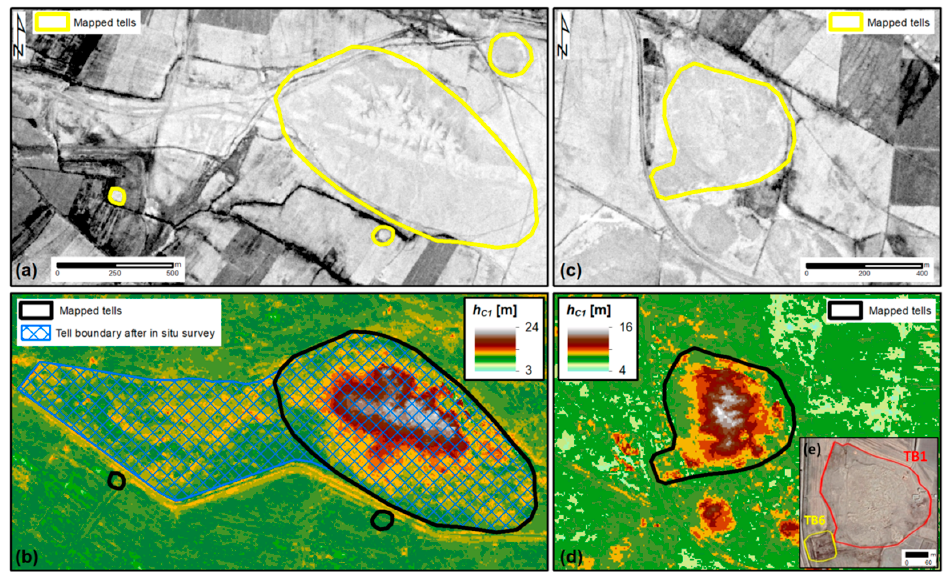
Figure 17. Zoomed views of tells ( a , b ) Bismaya H882 and ( c – e ) T ū l ū l al-Baqarat TB1 and TB6 showcasing the benefits of ground-truth and archaeological interpretation to verify, and even revise/refine, tell boundaries that are drawn via desk-based assessment of features and topographic relieves visible in CORONA imagery and a high resolution DEM product. Pictures ( b , d ) contain the CartoSat-1 DSM product (©GAF AG. Includes material ©Antrix, distributed by GAF AG); picture ( e ) contains Google Earth image (©2021 Maxar Technologies) collected on 3 October 2020.